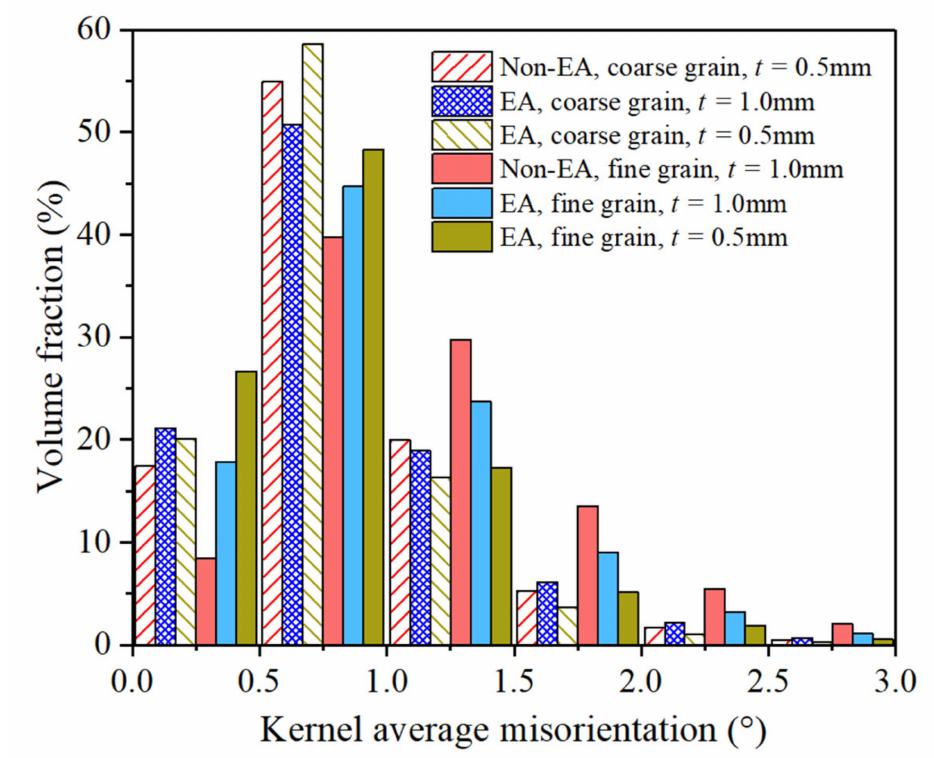
Figure 6. KAM histogram of the samples strained to 10% tension deformation. To verify the possible roles of the EPE in affecting dislocation slip and deformation twinning, the grain reference orientation deviation (GROD, the intragranular misorientation angle at each grid relative to the mean orientation of grains) maps of the deformed samples were computed from the EBSD data, and the results are shown in Figure 7. These GROD maps can be interpreted to estimate the shear strain due to dislocation slip in the constrained grains in polycrystals [26,27]. The GROD maps are heterogeneous in all samples. Most deformation twins have a very small GROD angle, which means these twins underwent less dislocation slip after the reorientation. On the contrary, grains without deformation twins have large GROD values; it is anticipated that these grains have crystallographic orientation more favorable to dislocation slip and less to deformation twinning, so they have large shear deformation associated with dislocation slip and larger GROD angles. Furthermore, hot spots (GROD angle close to 15 ◦ ) primarily occurred in small grains, in which deformation twinning was strongly suppressed due to their very small grain size. A noticeable feature exhibited in Figure 7 is that for the coarse grain samples, the EA samples have more grains with large GROD angles than the non-EA samples; this implies that dislocation slip contributed more plastic deformation in the EA samples. On the other hand, systematic differences among the non-EA and EA fine grain samples are not